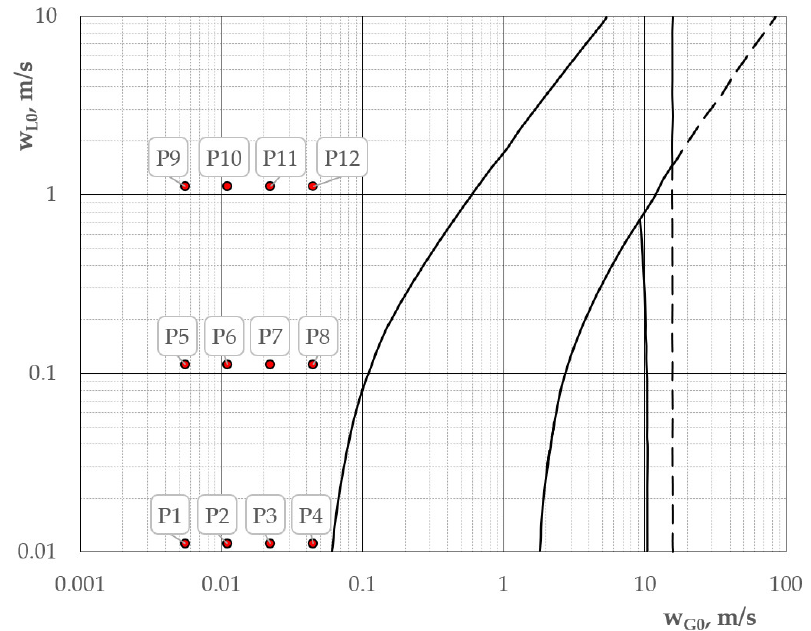
Figure 7. Two-phase flow map according to Mishima and Ishii for the narrow vertical rectangular channel with the research area shown (red dots).